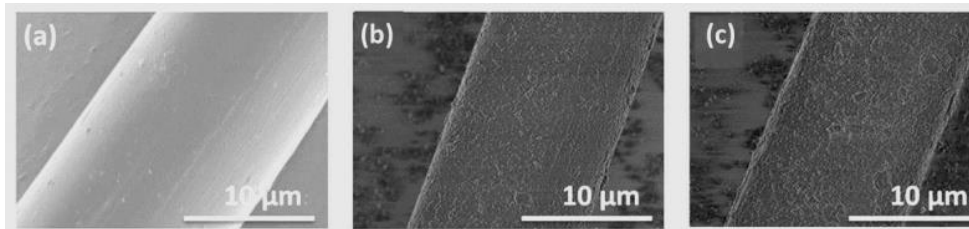
Figure 9. Surface morphology of aramid fibers before and after treatment with layer-by-layer self-assembly of L -PDOPA and electrostatic adsorption acidification of silane coupling agents (KH550): ( a ) AF; ( b ) 5L-AF; ( c ) 5L-AF-R.